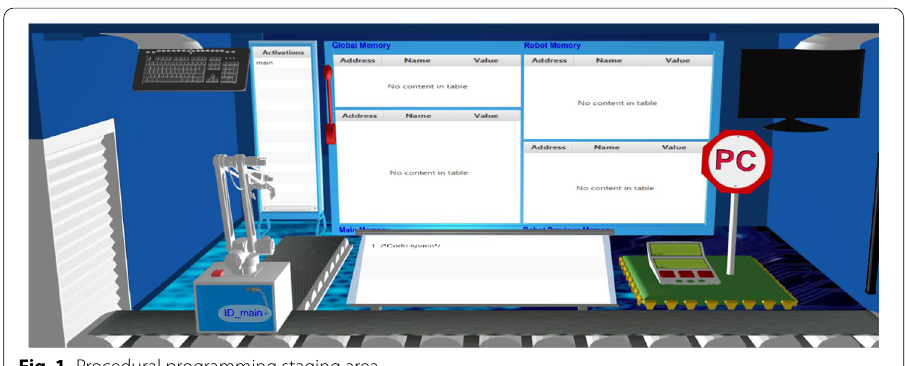
Fig. 1 Procedural programming staging